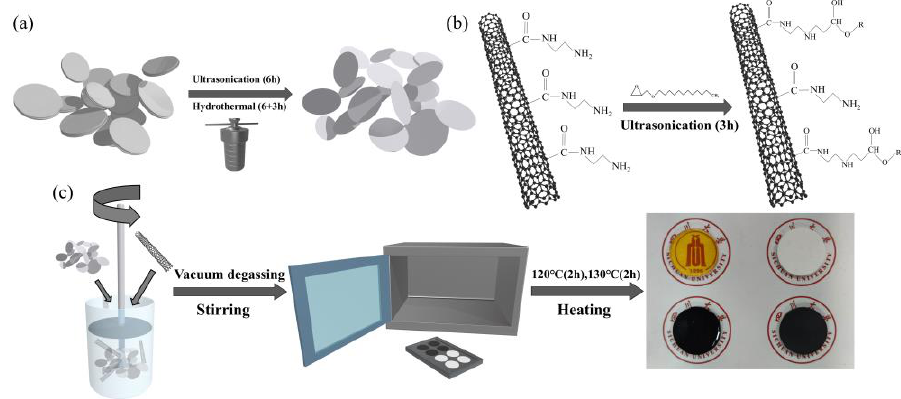
Figure 1. ( a ) Liquid-phase exfoliation process of h-BN; ( b ) surface functionalization of MWCNTs; ( c ) fabricating procedure of BNNSs/MWCNTs /SiO 2 /epoxy composites. ( c ) fabricating procedure of BNNSs/MWCNTs /SiO 2 /epoxy